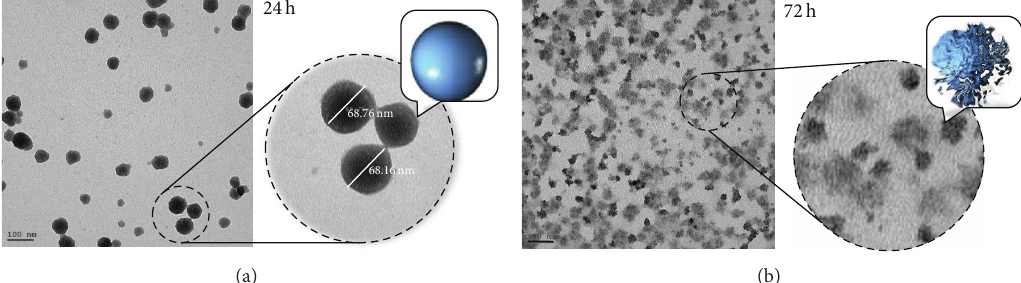
Figure 12: TEM micrograph images of TFN-loaded nanovesicles (a) at 24 h; scale bar is 100nm; (b) at 72 h; scale bar is 100nm; cartoon shows vesicles deformation over time.